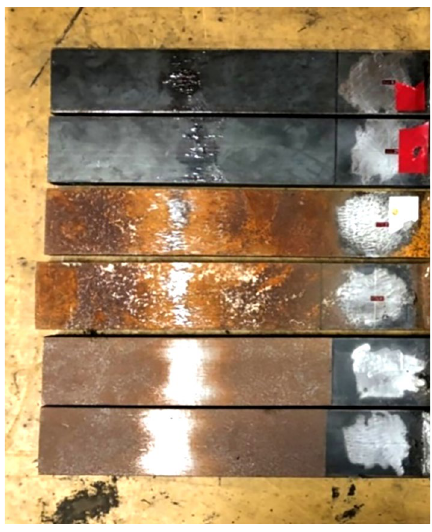
Figure 5. Surface of the specimens (Top 1, 2: unprocessed; middle 3, 4: rust; bottom 5, 6: shot blast)